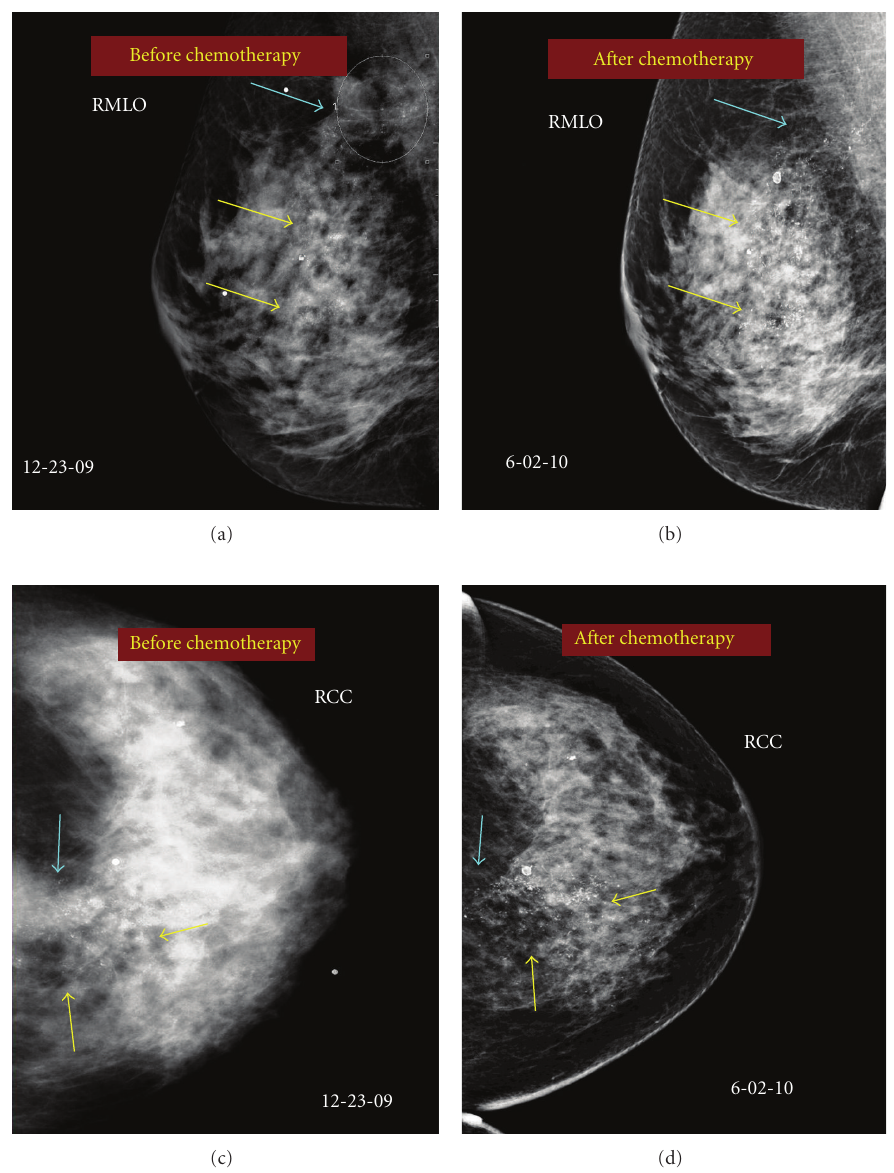
Figure 1: Comparison of mammographic studies before and after neoadjuvant chemotherapy. (a) Right MLO view prior to neoadjuvant chemotherapy. The blue arrow indicates the mass with surrounding microcalcifications. The yellow arrows indicate additional malignant- appearing microcalcifications occupying the upper part of the right breast. (b) Right MLO view after neoadjuvant chemotherapy. The blue arrow shows resolution of the mass but persistence of surrounding microcalcifications. The yellow arrows show persistence of the additional, extensive microcalcifications. (c) Right CC view prior to neoadjuvant chemotherapy. The yellow arrows indicate the areas of microcalcifications. The blue arrow indicates the breast mass. (d) Right CC view after neoadjuvant chemotherapy. The yellow arrows indicate the areas of persistent microcalcifications. The blue arrow shows complete resolution of the breast